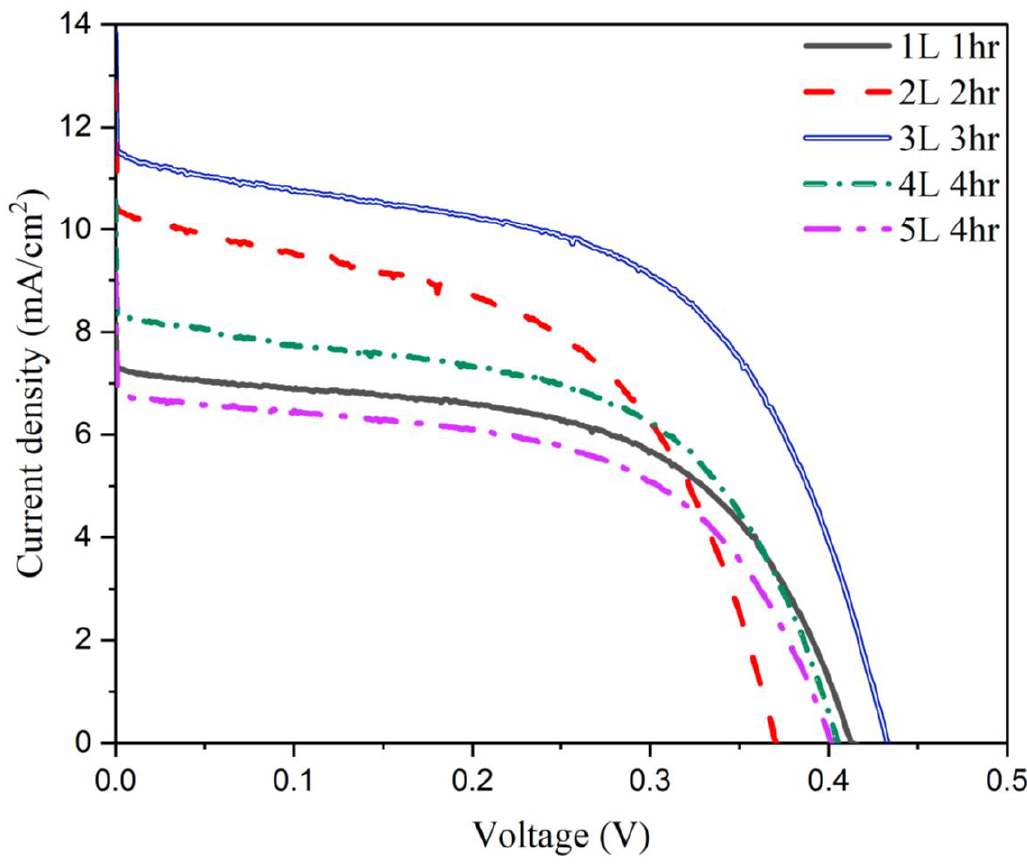
Figure 10. The J-V curve for the cell at optimal dye soaking time for each layer.